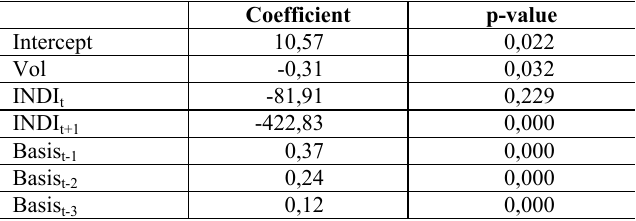
Table 5: Regression summary of implied volatility on basis – INDI